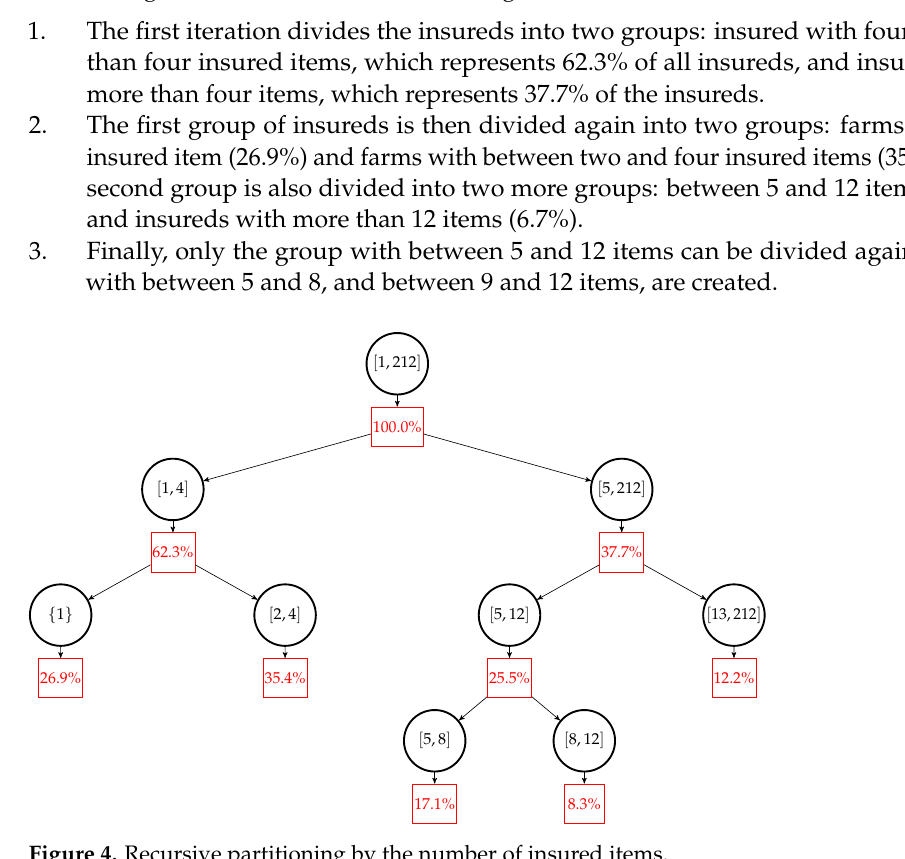
Figure 4. Recursive partitioning by the number of insured